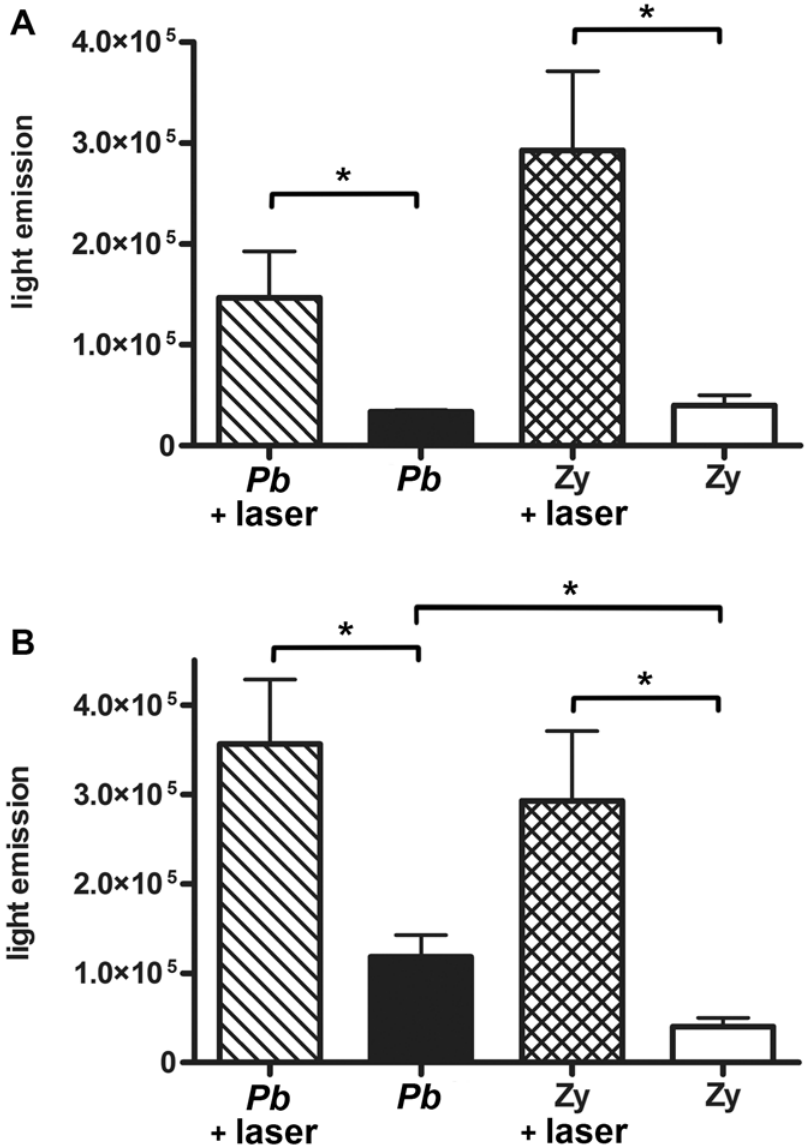
Fig 6. Quantification of reactive oxygen species (ROS) produced by PMN. Luminol chemiluminescence of ROS (photon counts x 10 4 per second) by light irradiated and non-irradiated PMN recruited by A — Pb or Zymosan (Zy): p = 0.0425 ( * ) between non-irradiated and irradiated PMN of Pb groups; p = 0.0325 ( * ) between non-irradiated and irradiated PMN of Zy groups; and B — Pb or Zy co-cultivated with Pb : p = 0.0356 ( * ) between the irradiated and non-irradiated PMN of the Pb group; p = 0.0325 ( * ) between the irradiated and non-irradiated PMN of the Zy group; p = 0.0406 ( * ) between the non-irradiated PMN of the Pb and Zy